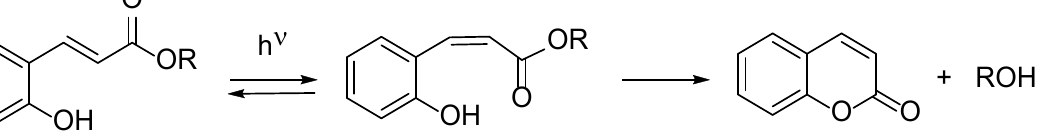
Figure 1. Photoisomerization and lactonization of E - o -hydroxy cinnamates. Substituents on the aromatic rings are omitted for the sake of clarity.